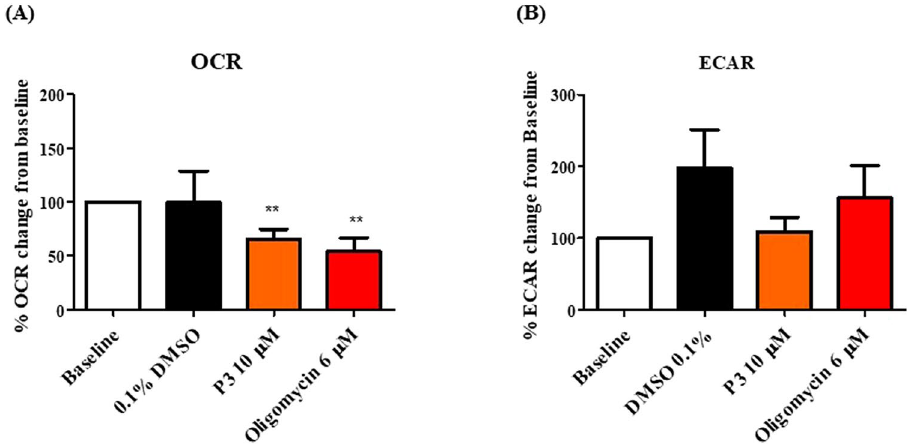
Figure 2. Pyrazinib (P3) significantly reduces OCR in OAC treatment-naïve biopsies. OCR and ECAR were measured in real-time using Seahorse Biosciences XFe24 analyser. ( A ) Percentage change from baseline of OCR following treatment with 0.1% DMSO control, 10 µM Pyrazinib (P3) or 6 µM Oligomycin for 24 h, (n = 10), Wilcoxon paired t-test, * p < 0.05. ( B ) Percentage change from baseline of ECAR following treatment with 0.1%